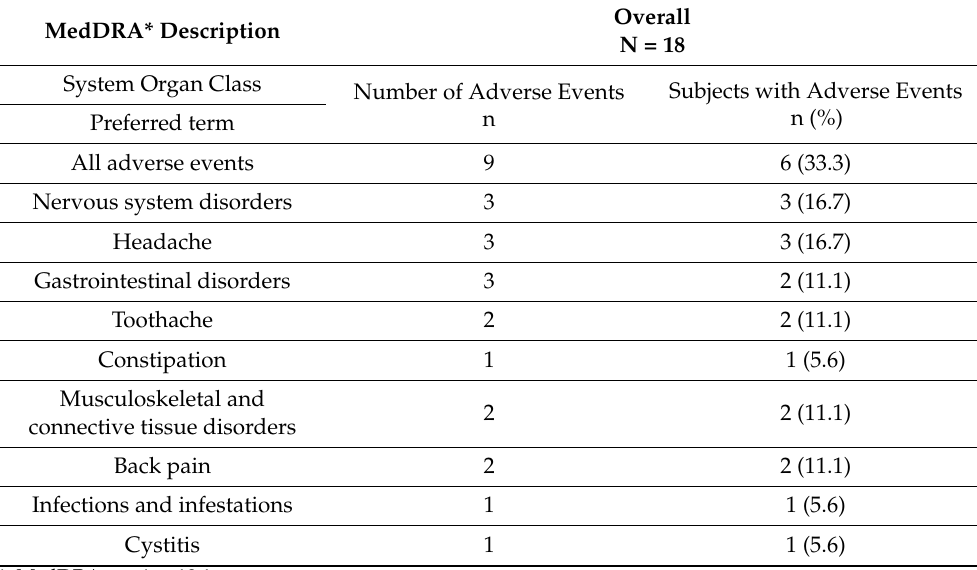
Table 7. Display of adverse events. Number of subjects reporting and number of reported adverse events by system organ class and preferred